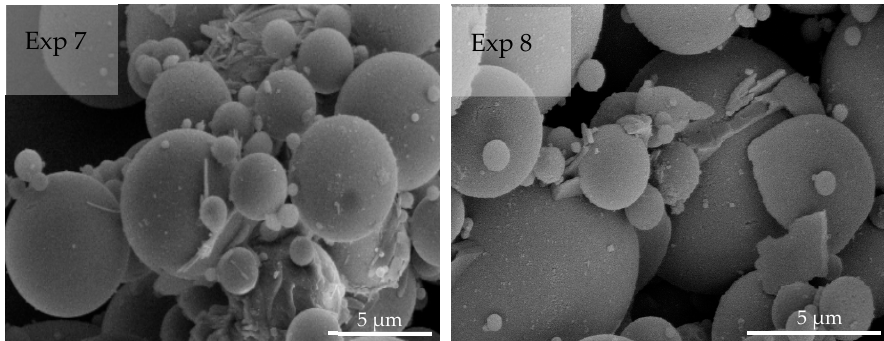
Figure 6. SEM images for deposition experiments 7 and 8.